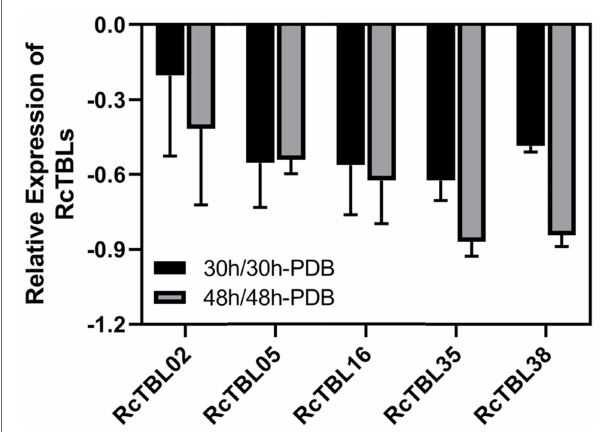
FIGURE 5 | Validation of RNA-Seq results using RT-qPCR. RcUBI2 was used as an internal control. Expression profile data of five RcTBL genes at 30 hpi and 48 hpi after B. cinerea inoculation were obtained using RT-qPCR. Values are the means of three technical replicates ± SD. The used primers are listed in Supplementary Table S1 .